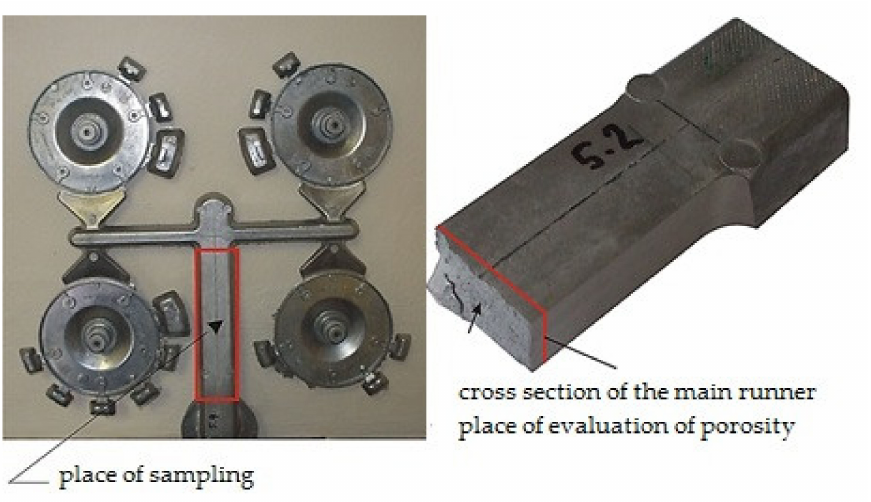
Figure 3. The sampling point for porosity